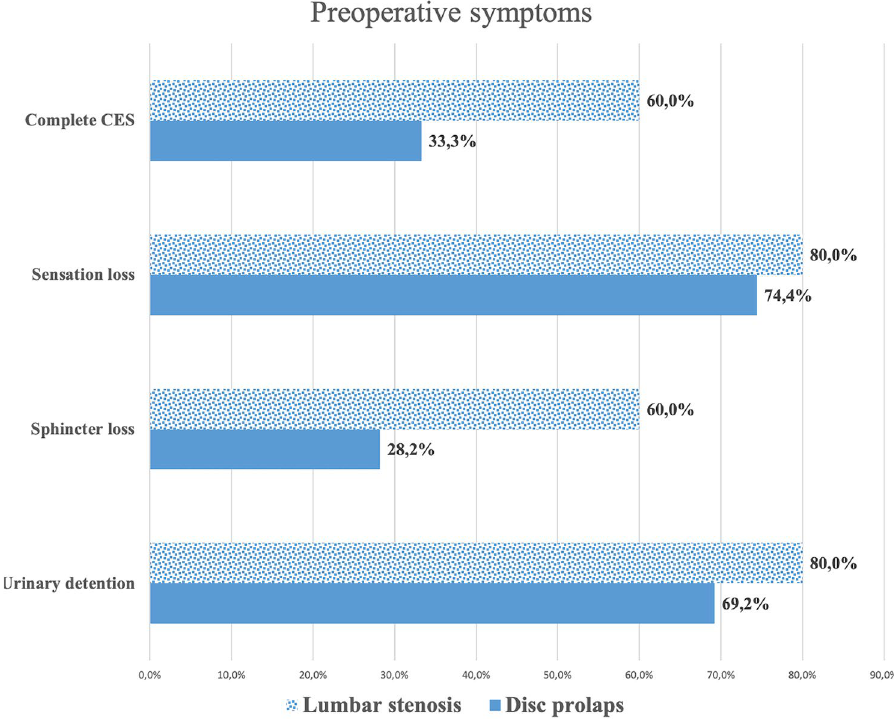
Figure 1. Preoperative symptoms described by patients with complete and incomplete cauda equina syndrome (CES).